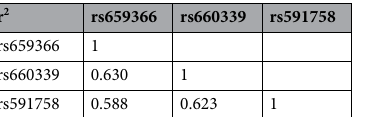
Table 4. Degree of linkage disequilibrium of the UCP2 SNPs between cases and